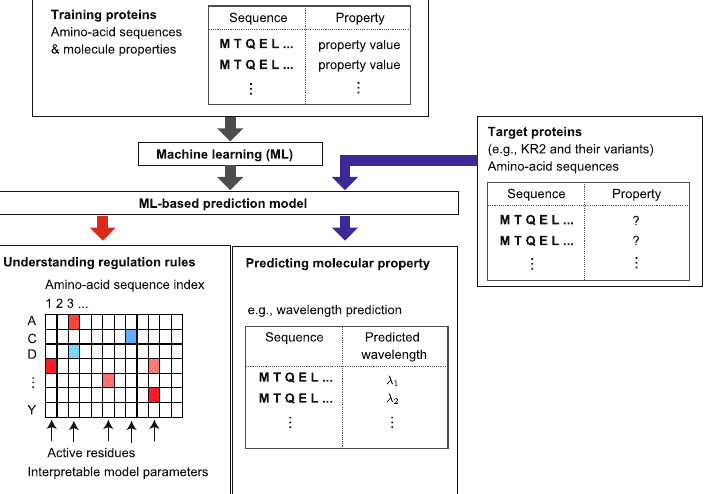
Figure 2. An overview of the machine-learning-based (ML-based) data-driven approach introduced in the present paper for functional protein studies. Using past experimental data, a training protein set containing pairs of amino-acid sequence and molecular properties is first constructed. Then, an ML method is applied to the training set, and an ML-based statistical model is constructed. The obtained ML model can be used in understanding the relationship between amino-acid sequences and molecular properties, such as the colour tuning rules in the case of microbial rhodopsins. The ML model can also be used to predict the molecular properties of new uninvestigated proteins. We refer to the set of new proteins as the target protein set . In the present paper, for the purpose of demonstration, we regard KR2 wildtype and its 118 variants as target proteins and other 677 rhodopsin proteins in the database as the training